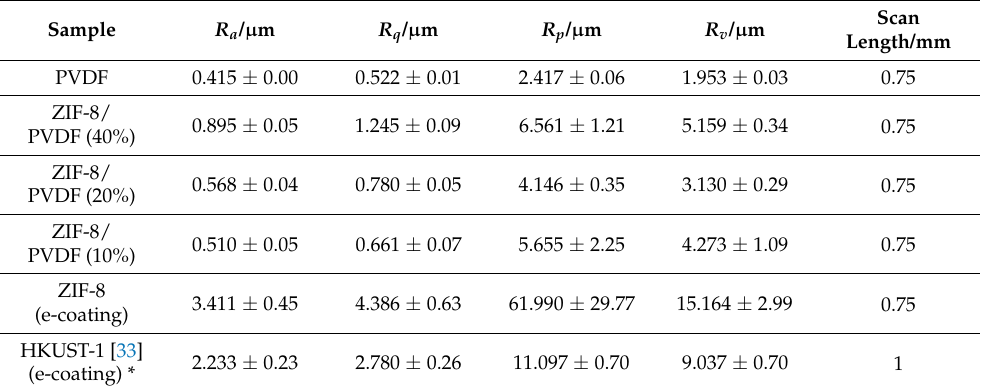
Table 1. Surface roughness parameters— R a : arithmetical average roughness , R q : root mean square roughness, R p : maximum peak height, R v : maximum valley depth for ZIF-8 and PVDF layers. The parameters for HKUST-1 were taken from ref. [33] and included for